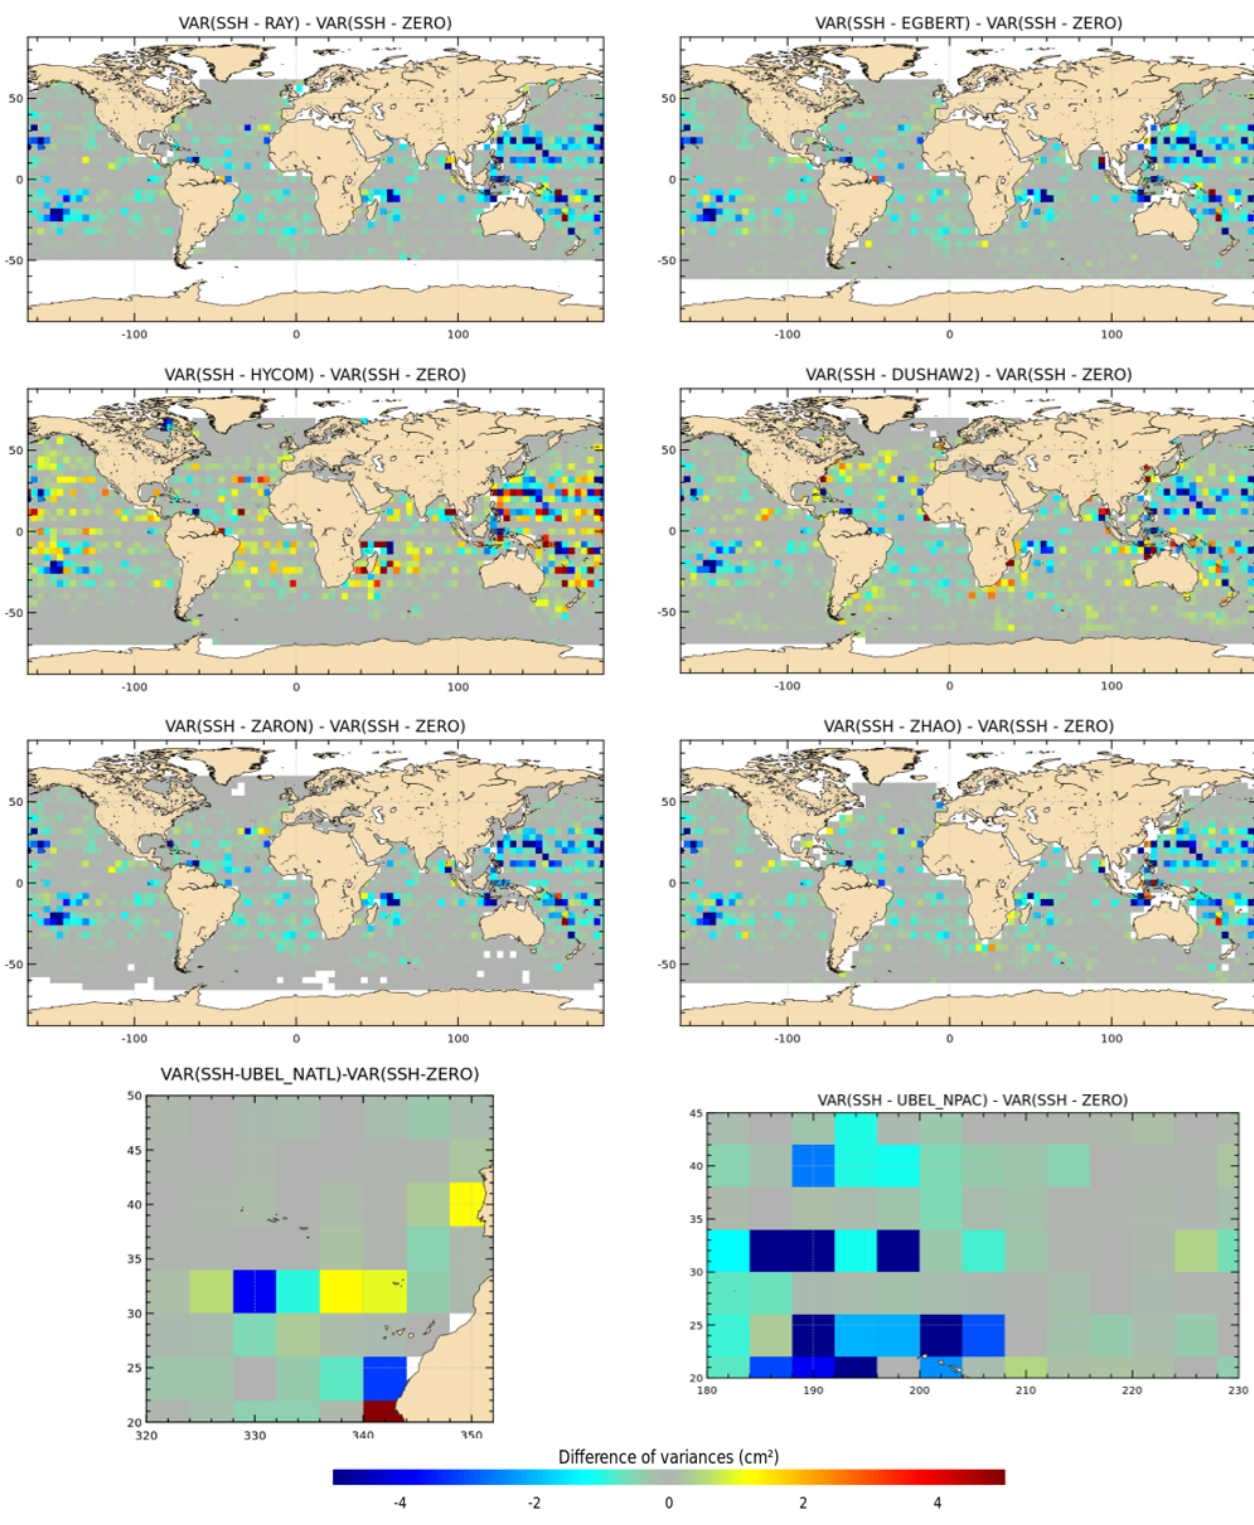
Figure 7. Maps of SSH variance differences at crossovers using either the M 2 IT correction from each model or a ZERO reference correction in the SSH calculation for the J2 mission (cm 2 ). J2 cycles 1–288 have been